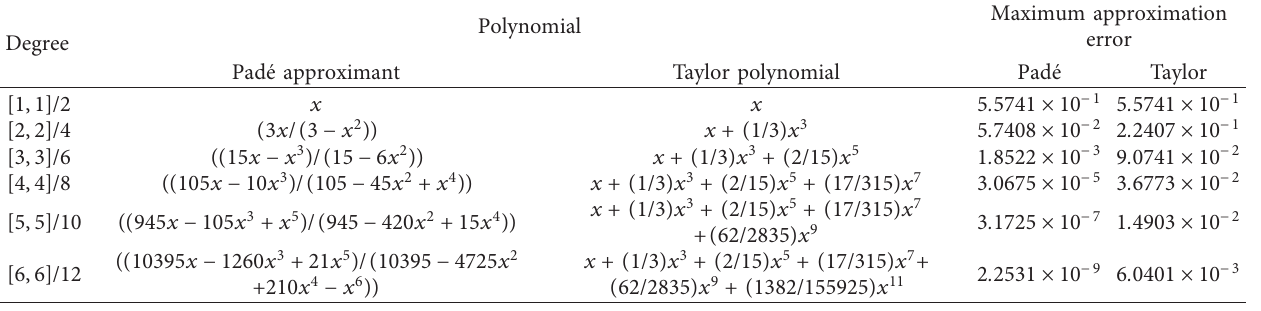
Table 1: Comparison between the Pad´e approximant and the Taylor polynomial for tan ( x )